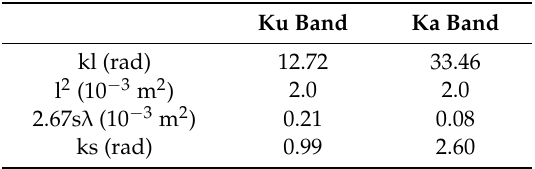
Table A2. Variables used for the validity of the GO